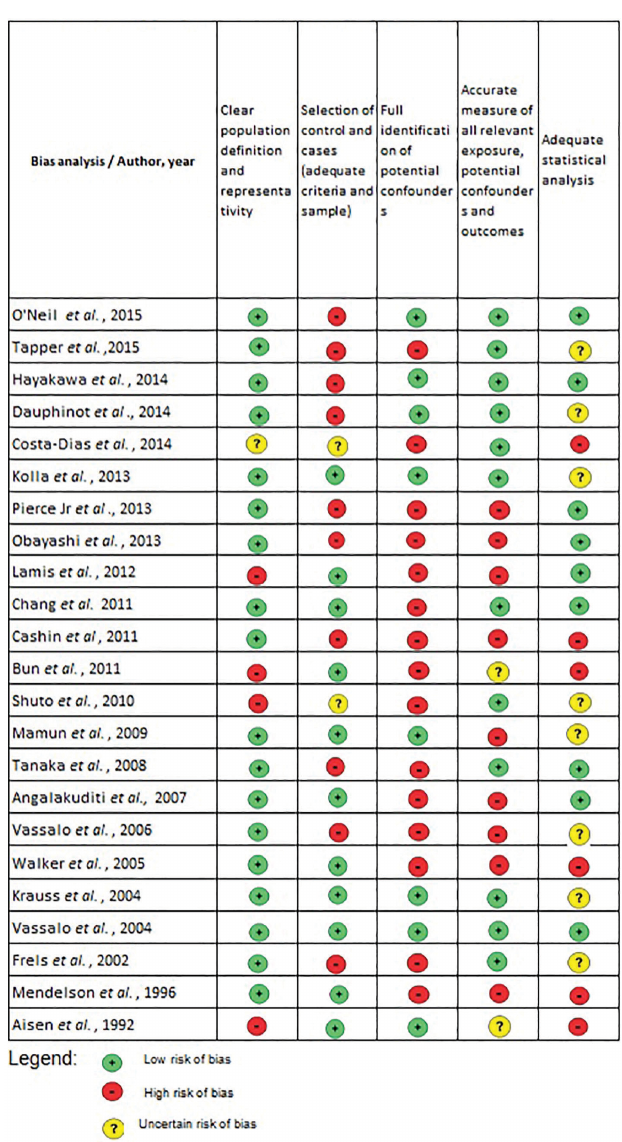
FIGURE 2 - Studies bias analysis (Tool adapted from STROBE (2007) and Young and Solomon (2009) proposition for critically appraise an